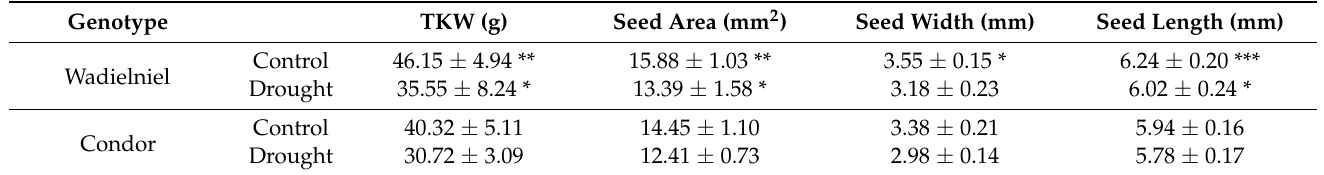
Table 2. Seed parameters presented as means ± SD. Statistical significances determined by a Student t -test between culti- vars in the same experimental condition. * p < 0.05, ** p < 0.01, *** p < 0.001.